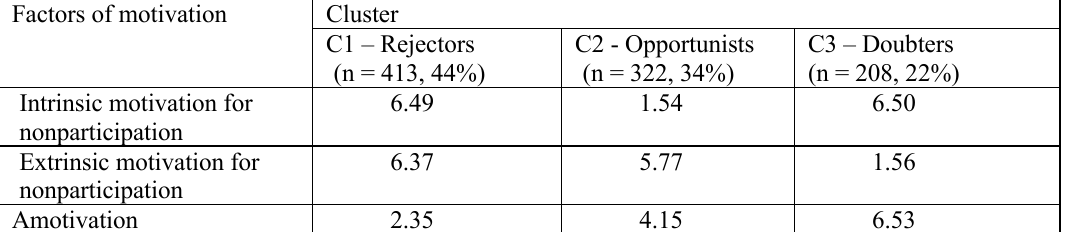
Table 2: Clusters of nonparticipants in ALE according to the prevailing type of motivation Factors of motivation Cluster C1 – Rejectors (n = 413, 44%)